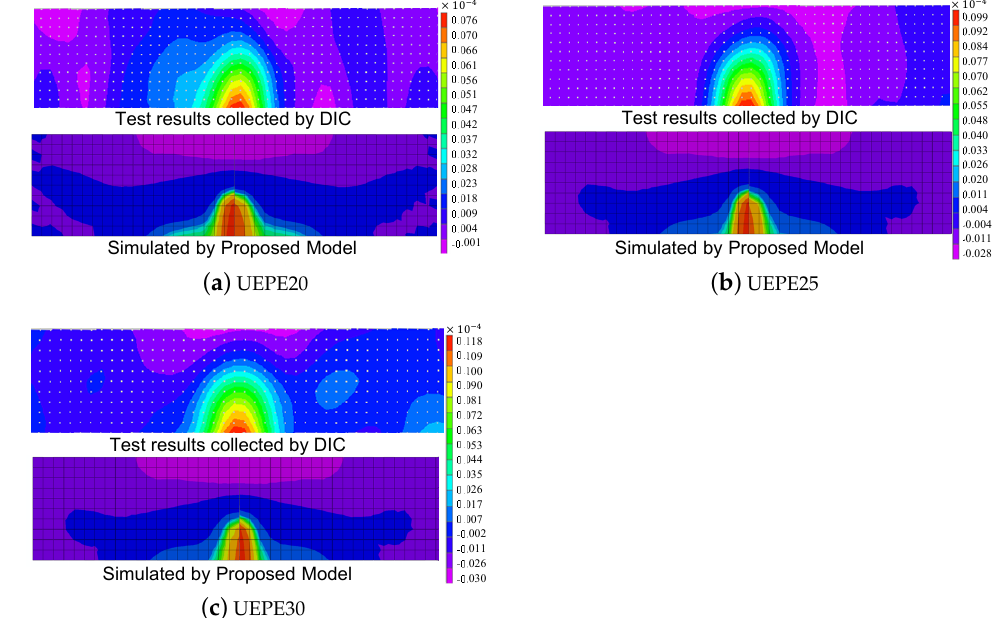
Figure 14. Strain distribution of specimens at the initial cracking